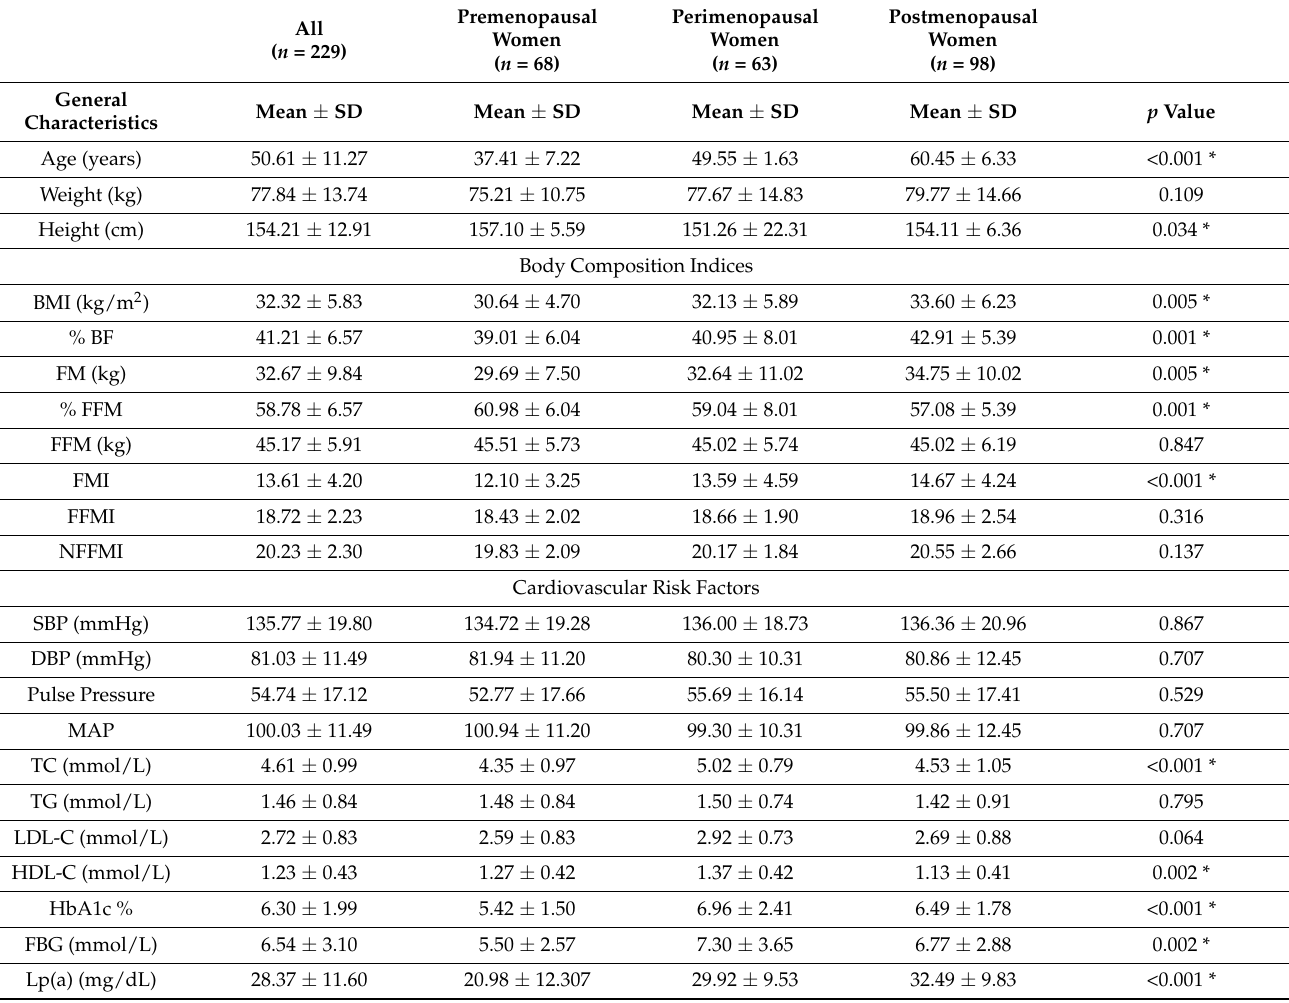
Table 1. Anthropometrics, clinical and biochemical characteristics by menopausal